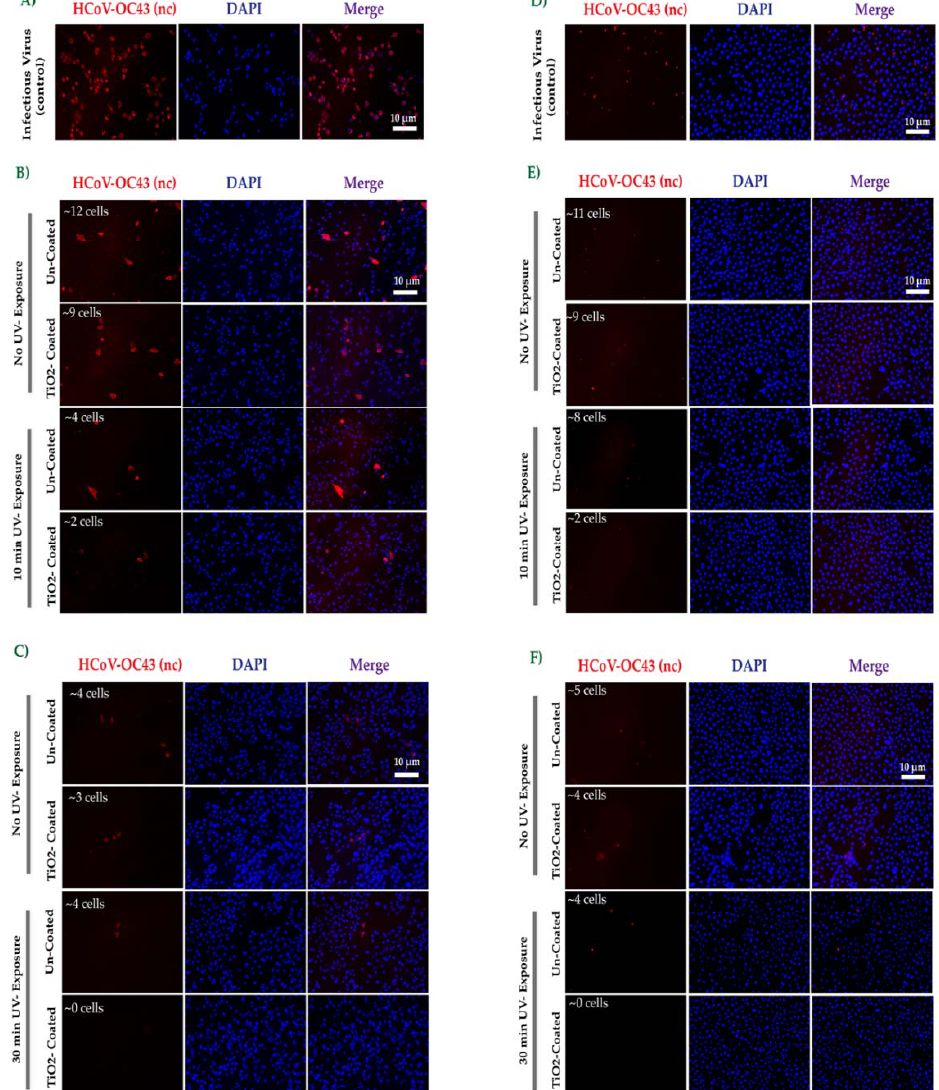
Figure 4. Immune Localization of HCoV ‐ OC43 nucleocapsid (nc) protein in virus ‐ infected cells using immunofluorescence assay. An average number of HCoV ‐ OC43 nucleocapsid stained (infected) cells, calculated from 3 different optical fields from each treatment, are shown in respective panels. ( A ). HCoV ‐ OC43 stock virus ‐ infected A549 ‐ hACE2 cells. Detection of virally infected A549 ‐ hACE2 cells added with viruses collected from the TiO2 ‐ coated and uncoated surfaces without and with UV exposure for ( B ) 10 min and ( C ) 30 min. ( D ) HCoV ‐ OC43 stock virus ‐ infected Vero ‐ ACE2 cells. Detection of virally infected Vero ‐ ACE2 cells added with viruses collected from the TiO2 ‐ coated and uncoated surfaces without and with UV exposure for ( E ) 10 min and ( F ) 30 min. Infection of these cells by the residual live HCoV ‐ OC43 virus led to the expression of viral nucleocapsid protein and staining with anti ‐ nucleocapsid antibody (red signals). Nuclei were stained with DAPI (blue signals). The infected cells were identified and quantified using the automated Image J macro method.